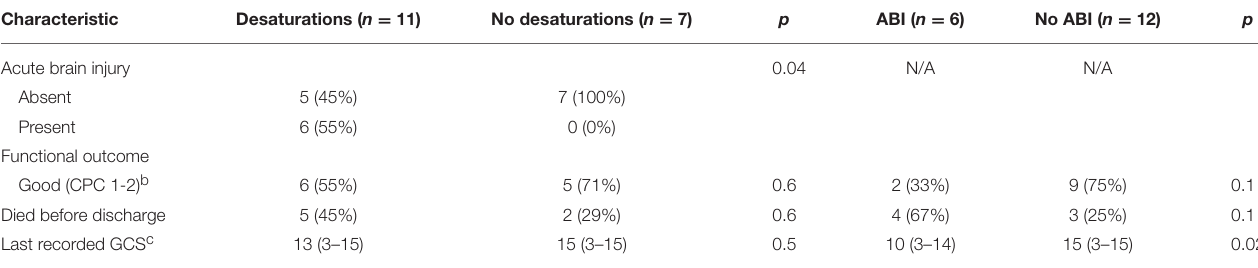
TABLE 4 | Patient outcomes a .